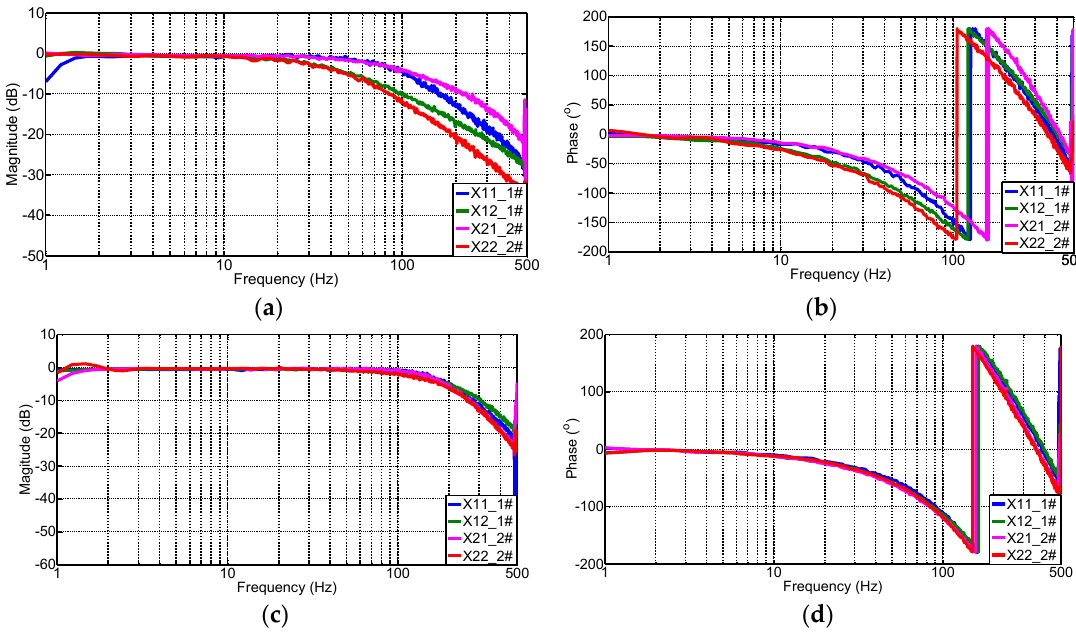
Figure 14. The frequency characteristics before and after tuning valve controllers. ( a ) Magnitude frequency characteristics before; ( b ) Phase frequency characteristics before; ( c ) Magnitude frequency characteristics after; ( d ) Phase frequency characteristics after.